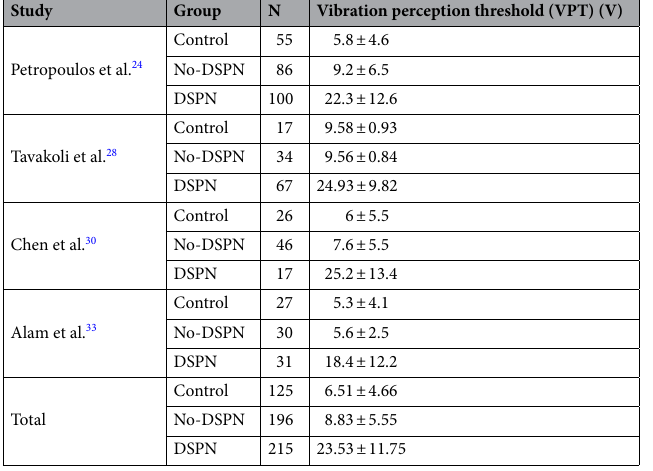
Table 3. VPT from studies 24,28,30,33